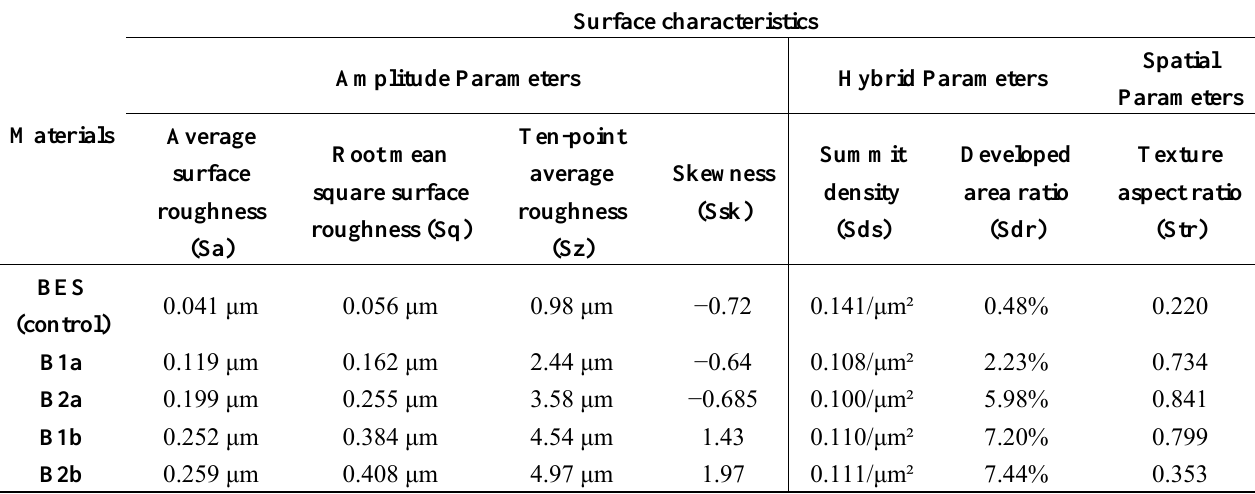
Table 2. The main surface characteristics of the tested implant material surfaces.